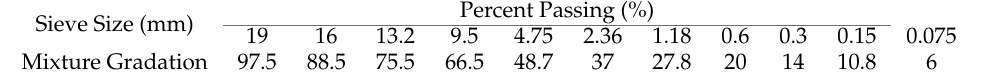
Table 1. AC-20C asphalt mixture grading range